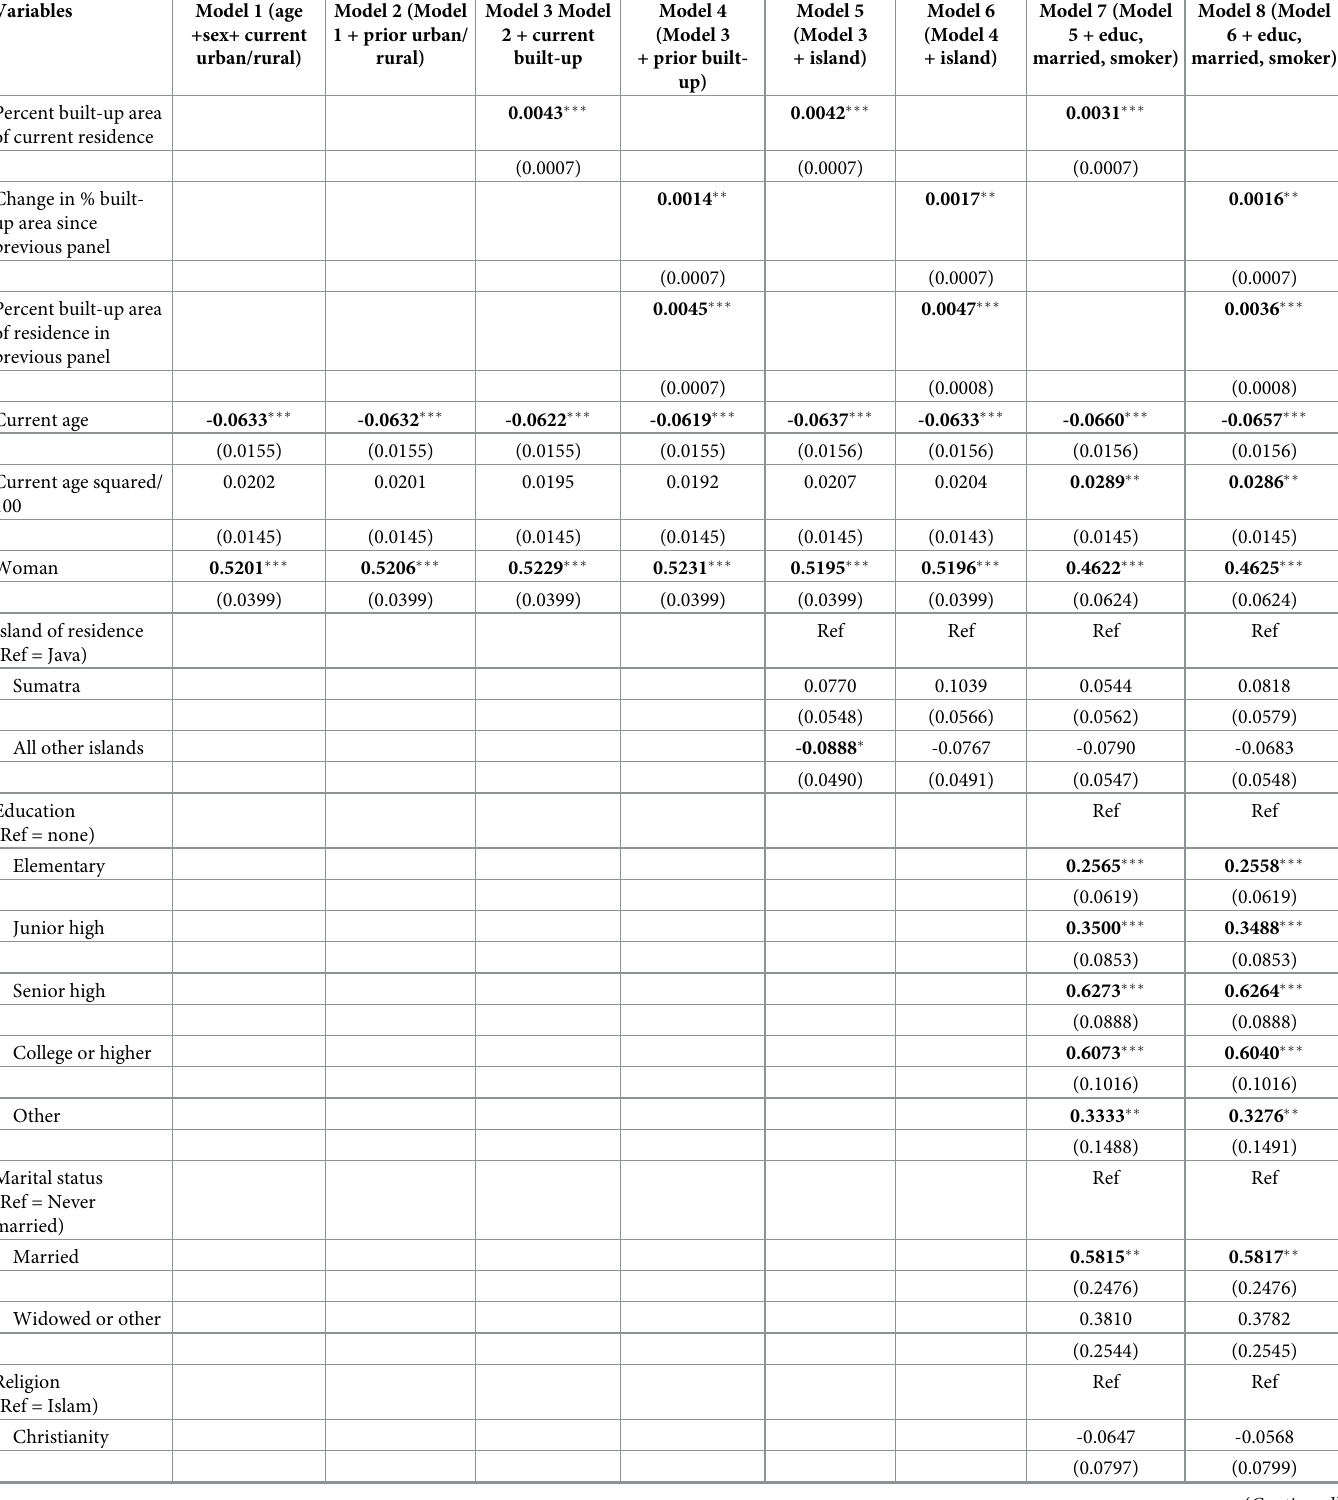
Table 4. Value-added linear regression model predicting BMI, pooled